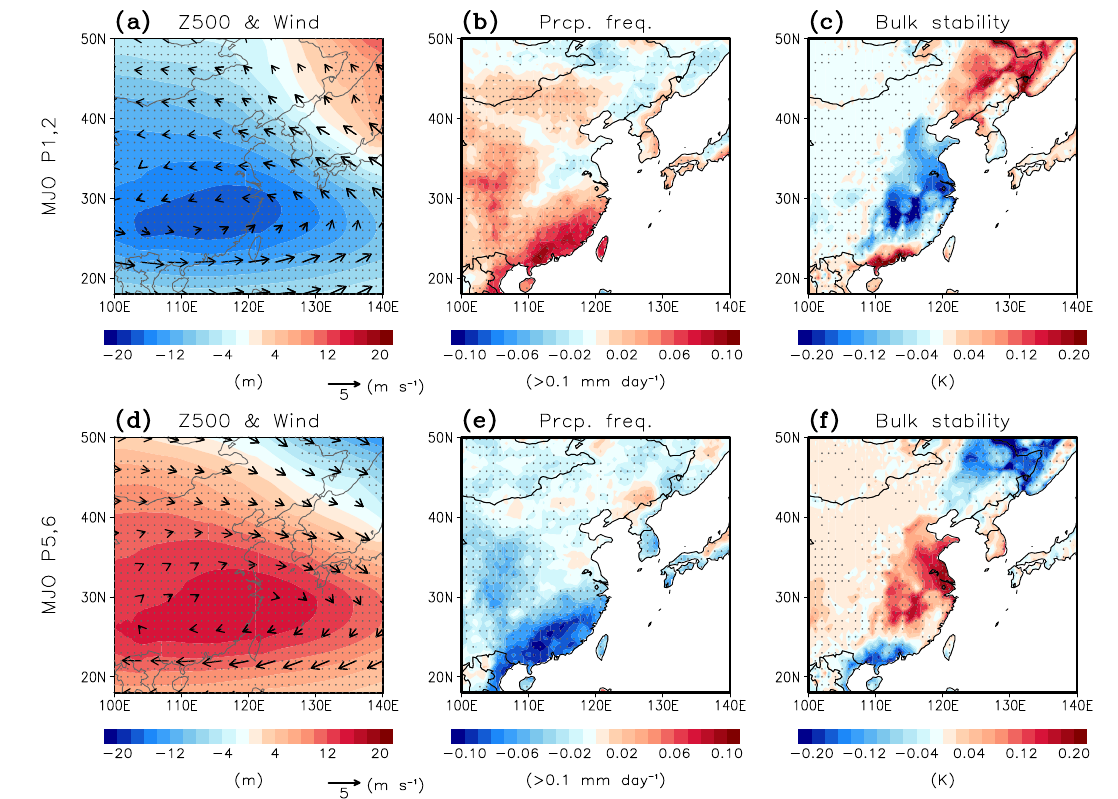
Fig. 4 | Atmospheric circulation anomalies during Madden – Julian Oscillation (MJO) phases 1 – 2 and 5 – 6. Composite anomalies of ( a ) 500-hPa geopotential height (Z500) (shading) and wind (vectors), ( b ) precipitation frequency which is countedasoneifthedailyprecipitationexceeds0.1mmday − 1 ,and( c )bulkstability which is de fi ned as potential temperature difference between 925 hPa and